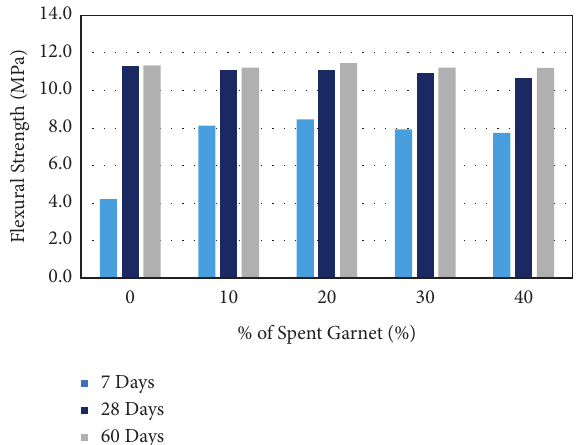
Figure 11: Flexural strength of POC LWAC containing spent